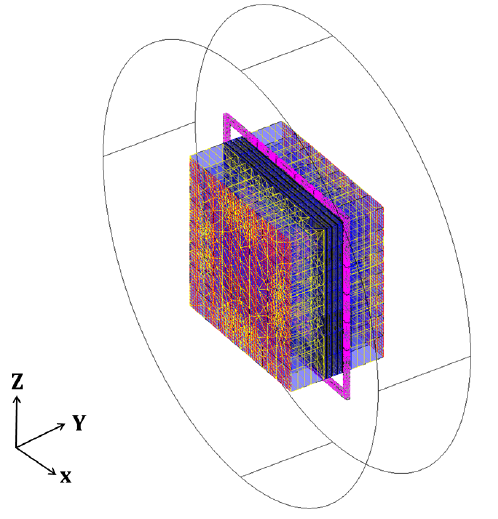
Figure 10. FEM passivized